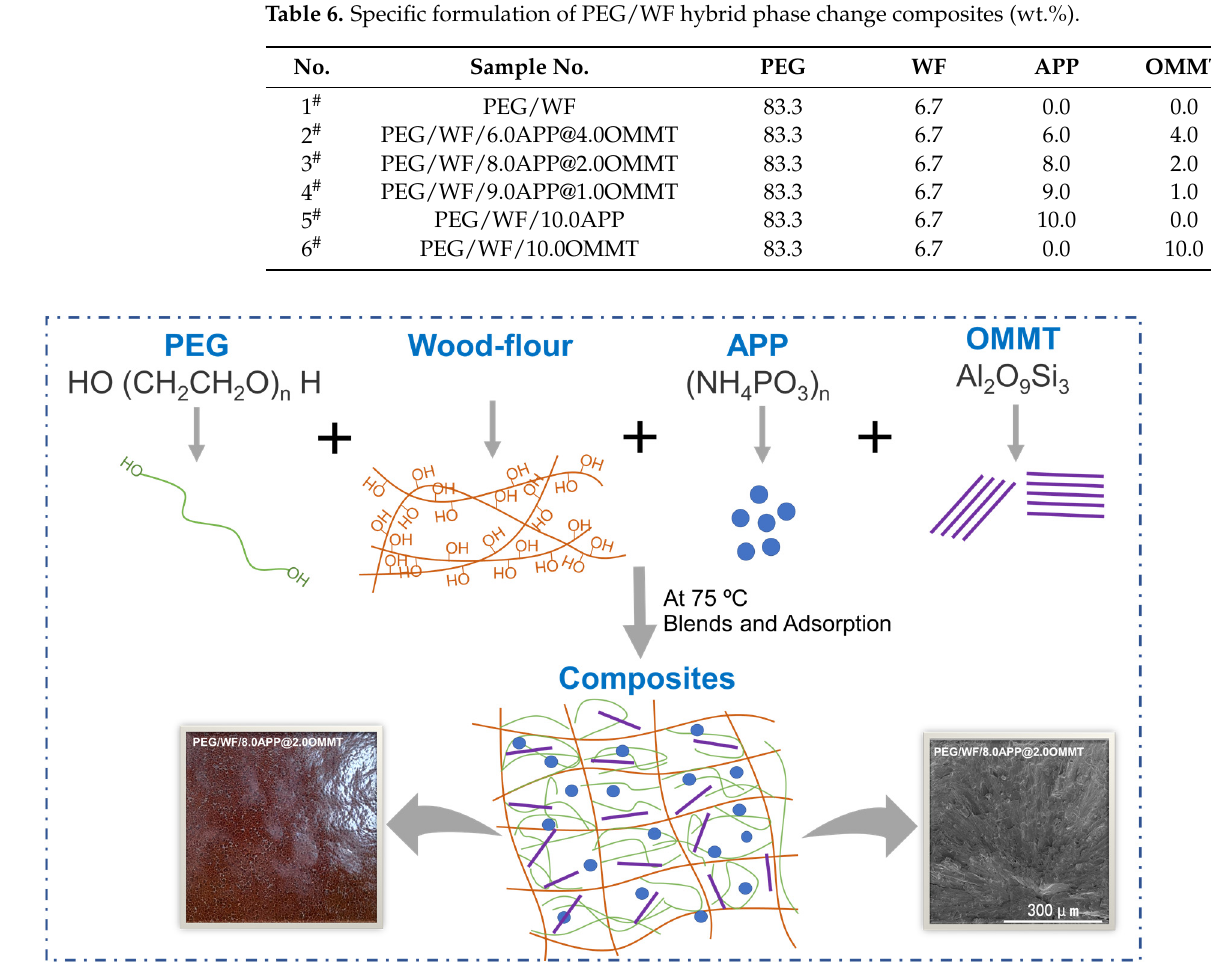
Figure 11. The synthetic route of PEG/WF composites. Table 6. Speci fi c formulation of PEG/WF hybrid phase change composites (wt.%) .